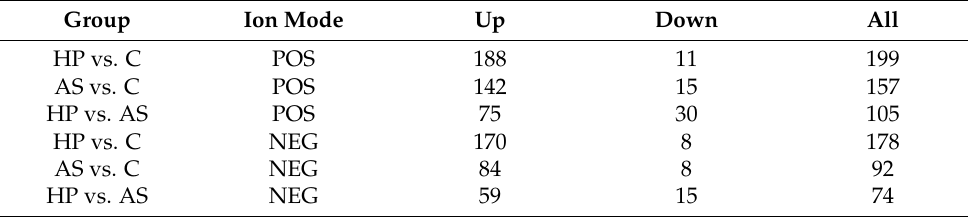
Table 4. Number of significantly different metabolites among different groups.